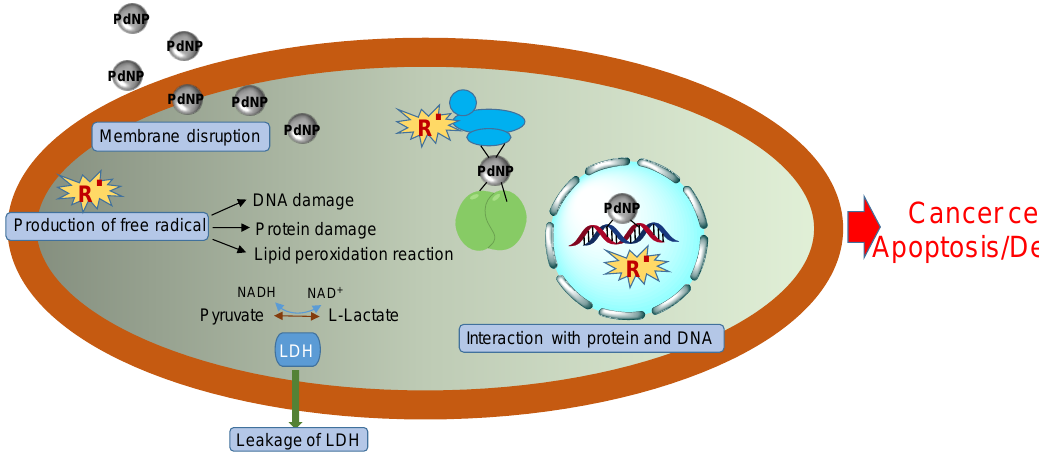
Figure 2. Illustration of the antitumor mechanism of PdNPs. The antitumor mechanism of PdNPs includes the physicochemical interaction of PdNPs with the functional groups of proteins, with nitrogen bases, phosphate groups of DNA, the generation of free radicals, the leakage of lactate dehydrogenase (LDH), and the disturbance of the cell cycle.